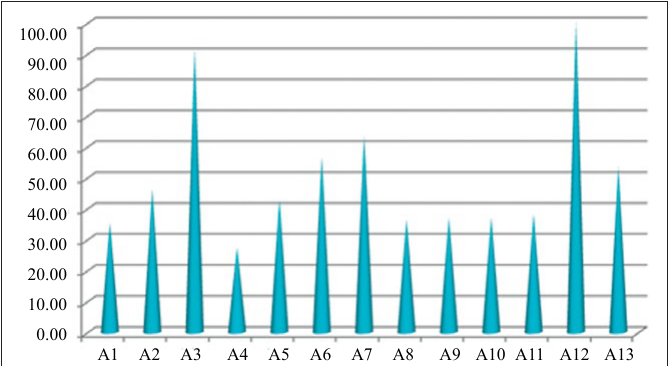
Fig. 3. The utility degrees of alternatives obtained by AHP-COPRAS (Case